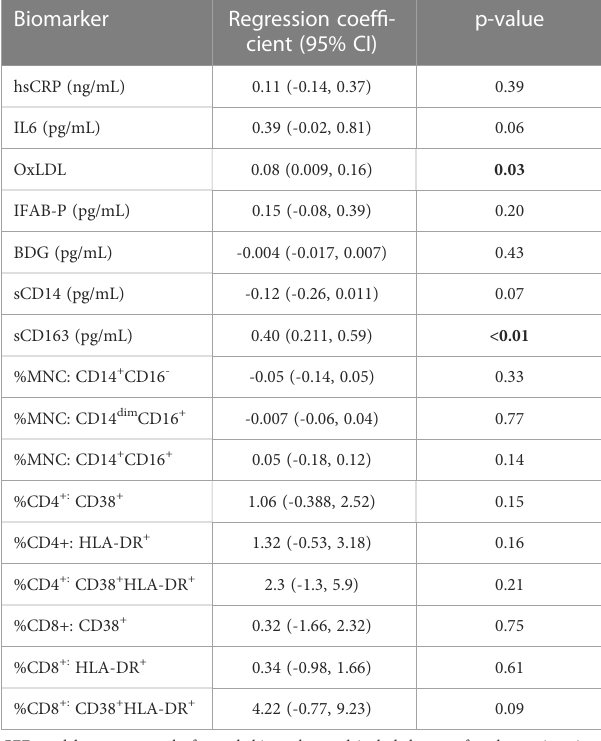
TABLE 3 Analysis of association between dolutegravir switch during study and changes in in fl ammatory biomarkers.